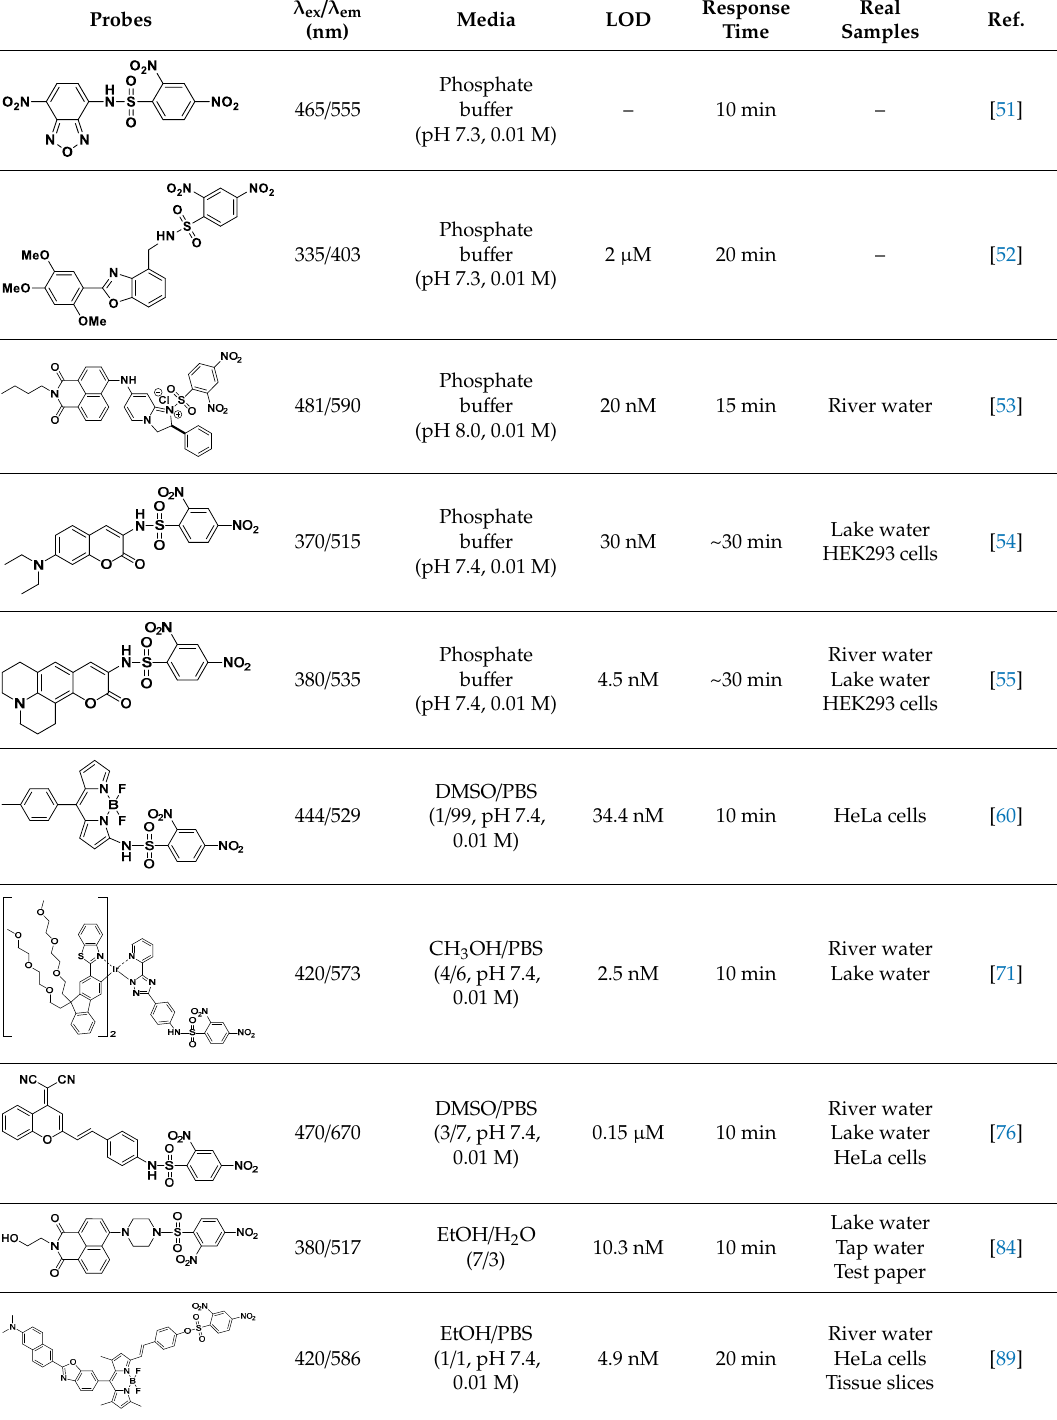
Table 1. Comparison of fluorescent probes for thiophenol (PhSH). Probes